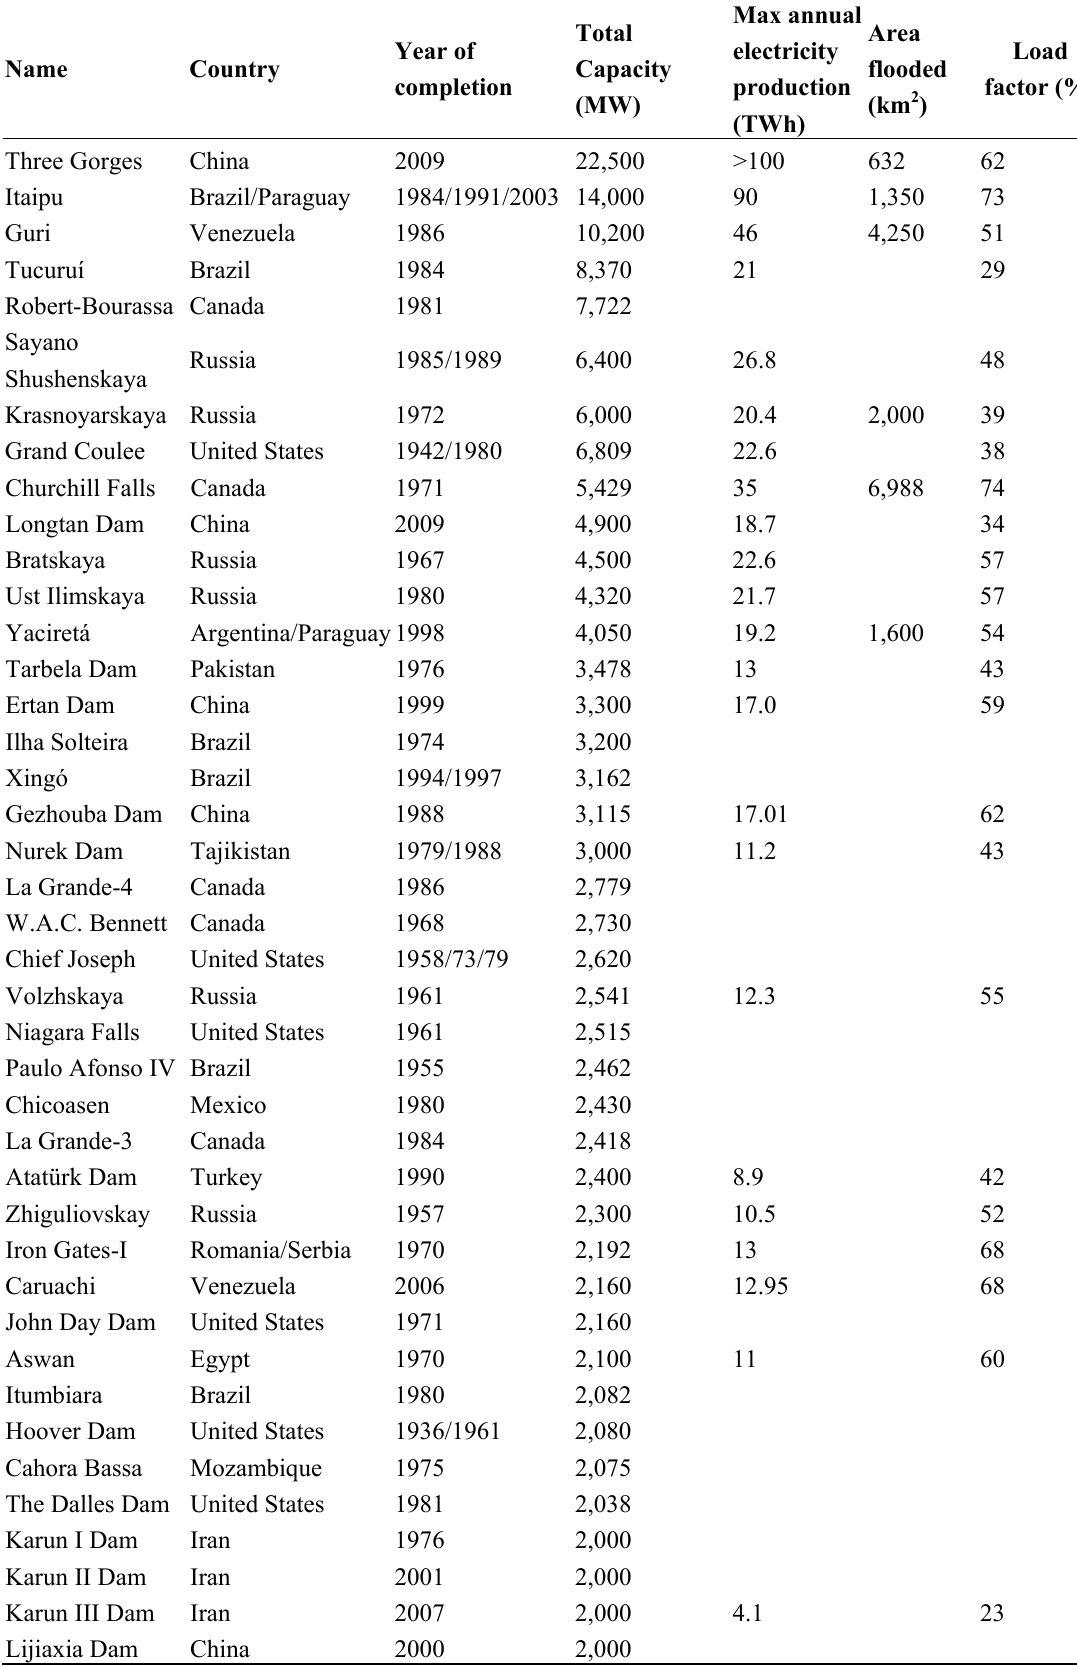
Table 6. List of the largest hydroelectric power stations (en.wikipedia.org/wiki/